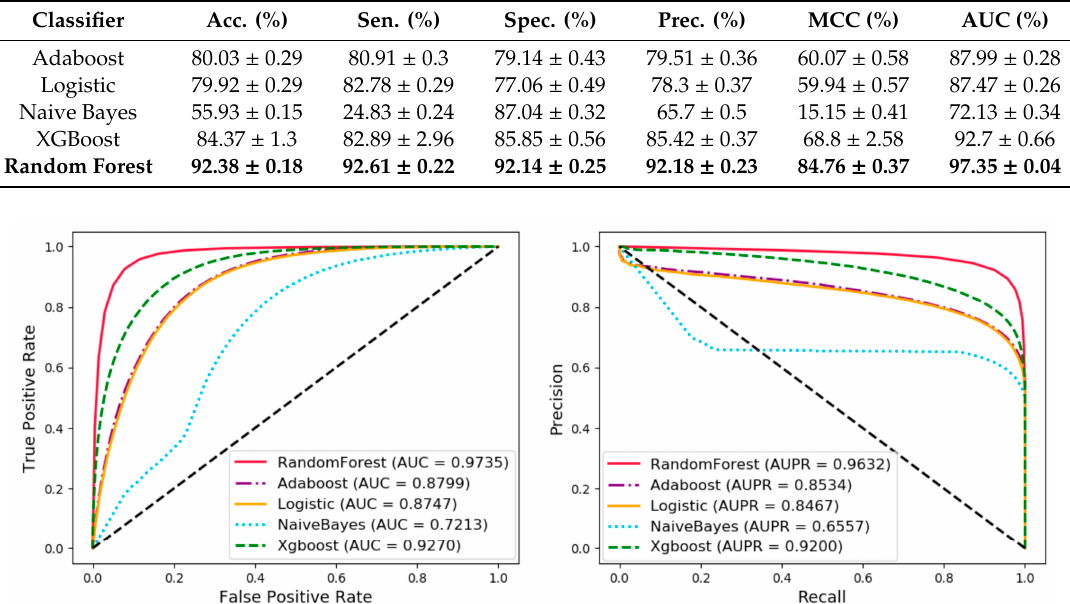
Table 5. Comparison of different classifiers.